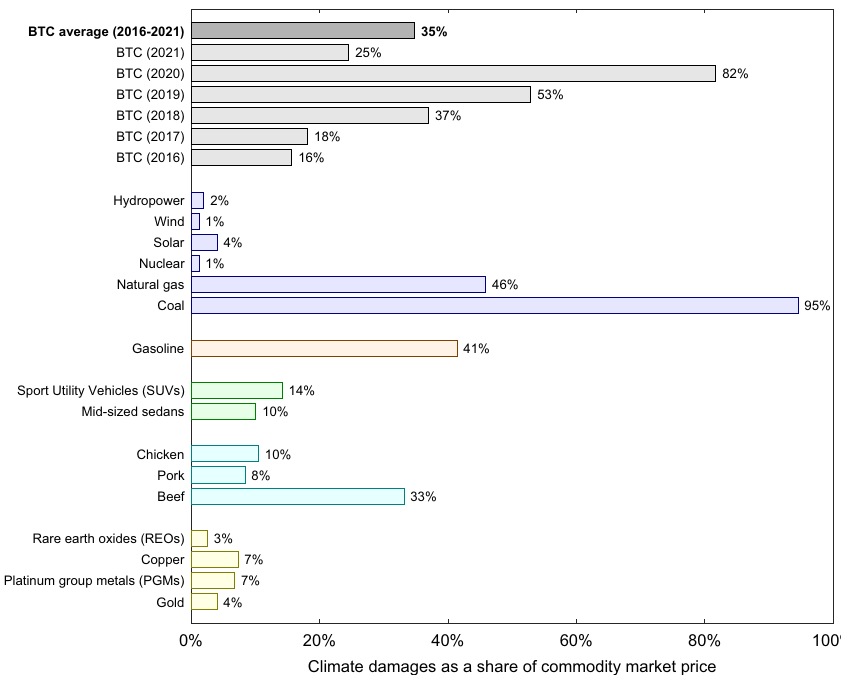
Figure 3. Bitcoin (BTC) mining’s climate damages as a share of coin market price (2016–2021), compared with full lifecycle analysis climate damages as a share of market price for other commodities (for a single year). Damages are expressed in percentage terms (% of market price). BTC climate damages only include energy use and emissions from running mining rigs, and do not include climate damages associated with cooling